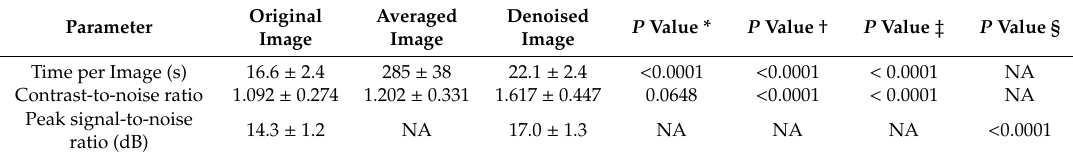
Table 1. Di ff erences in quantitative metrics among single, averaged, and denoised image in optical coherence tomography angiography images.